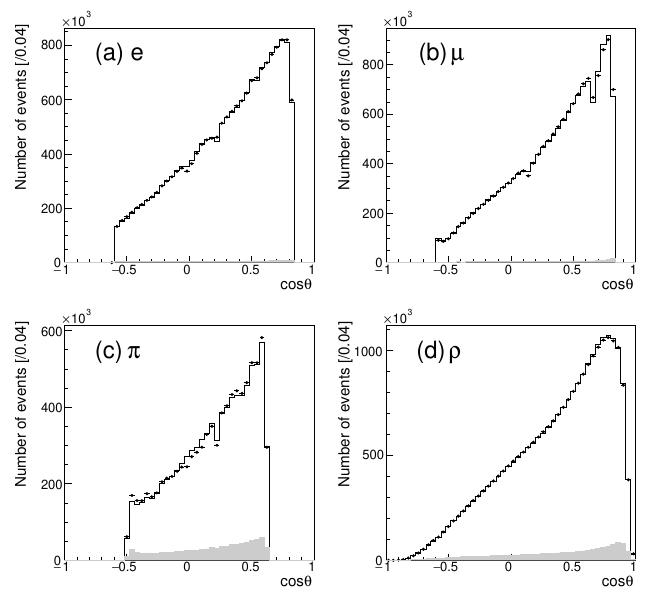
Figure 2 . The cos θ distributions of (a) electrons, (b) muons, (c) pions, and (d) ρ mesons for the samples obtained after all event selections in each mode. The points with error bars are the data, the solid histograms are the MC expectation, and the gray shaded histograms are the contribution from misidentification for each particle